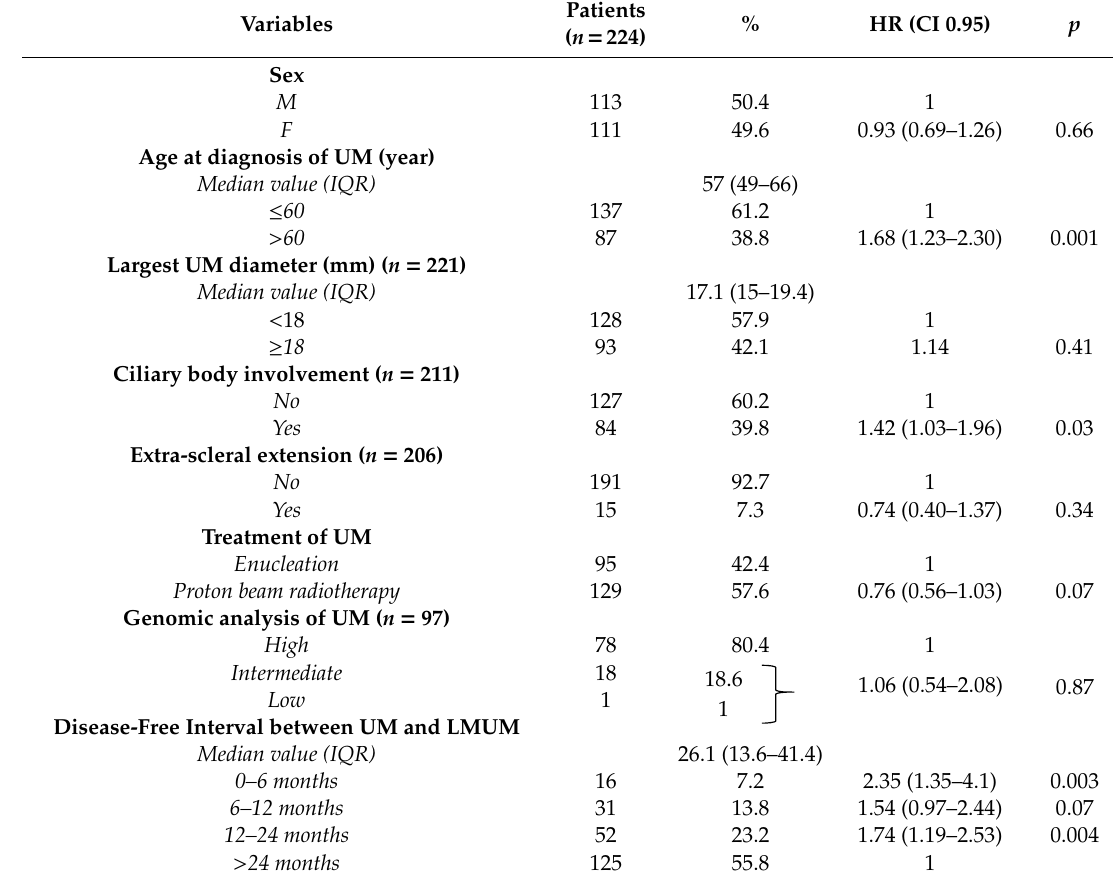
Table 1. Univariable analysis of factors associated with overall survival after diagnosis of liver metastases of uveal melanoma (LMUM).